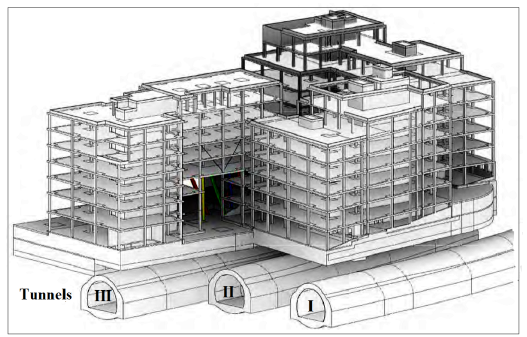
Figure 4. Vinohrady Administration Centre complex ([2] –